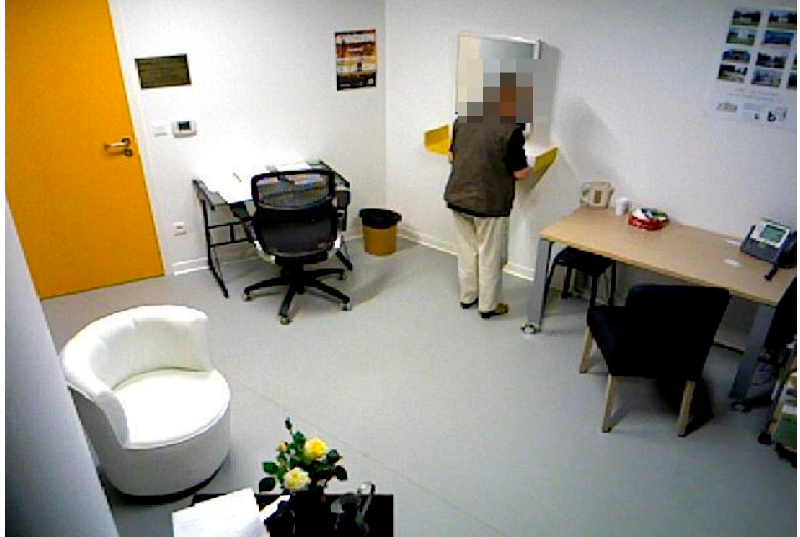
Figure 2. Nice protocol installation.